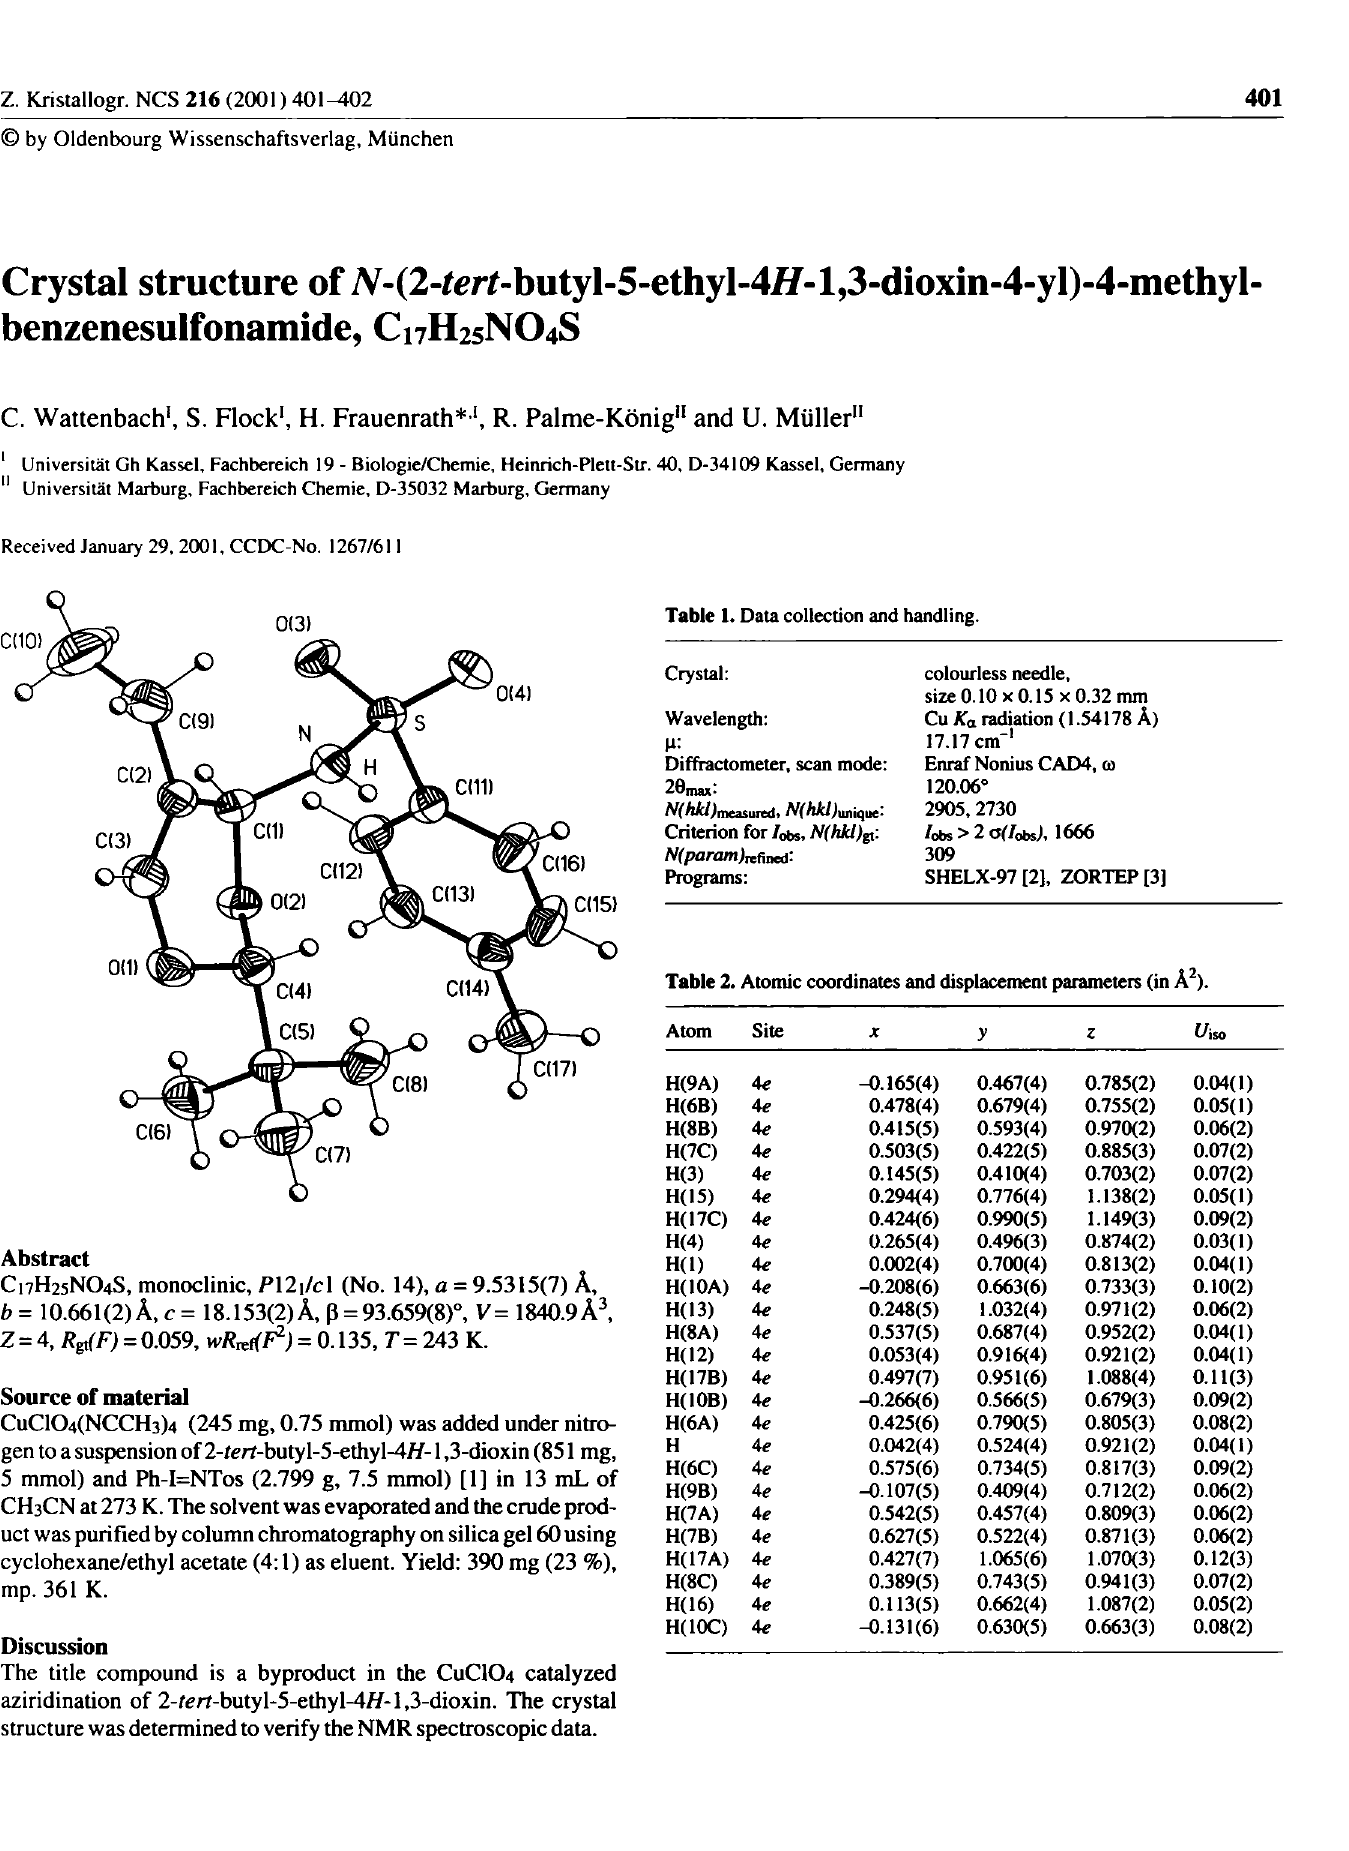
Table 2. Atomic coordinates and displacement parameters (in A 2